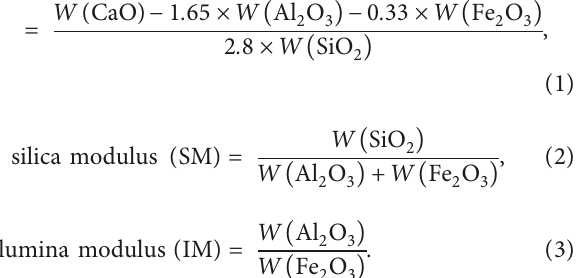
Figure 1: XRD pattern of GTs.